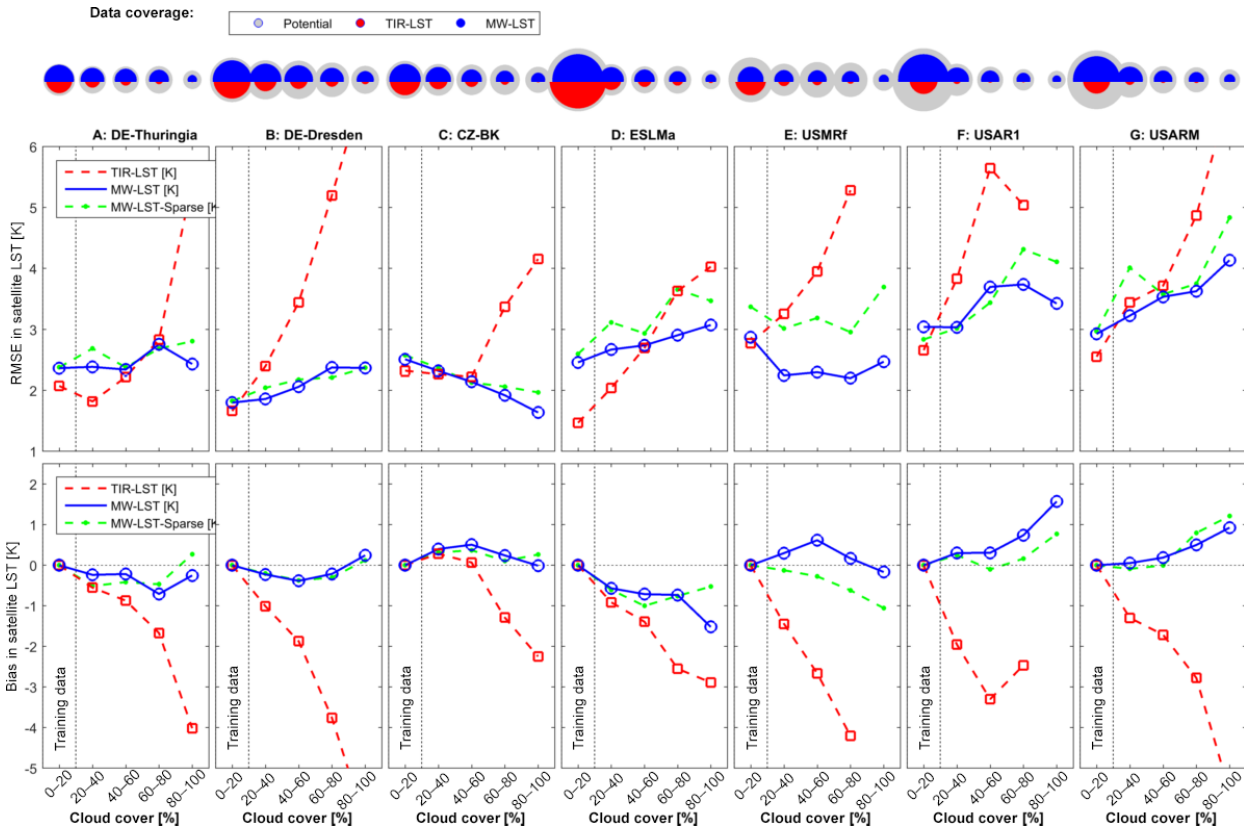
Figure 3. RMSE and bias of satellite LST with regression-corrected in situ data for five levels of cloud cover (( A cloud , Eqs. 8–10). From left to right are locations A–G (see Table 1 for site information). Results for TIR-LST (red) are contrasted with those for MW (blue). Markers indicate that more than 15 days with data were available for a particular cloud cover bin. Green dashed lines indicate the results for MW- LST-Sparse. For each site and cloud interval the percentage coverage of the temporal record is depicted in the top row with half-rounds in proportion to the number of data pairs. The potential number of data pairs (grey) refers to the number of in situ data points for each cloud bin. The actual number of data pairs is superimposed on this for MW (blue) and TIR